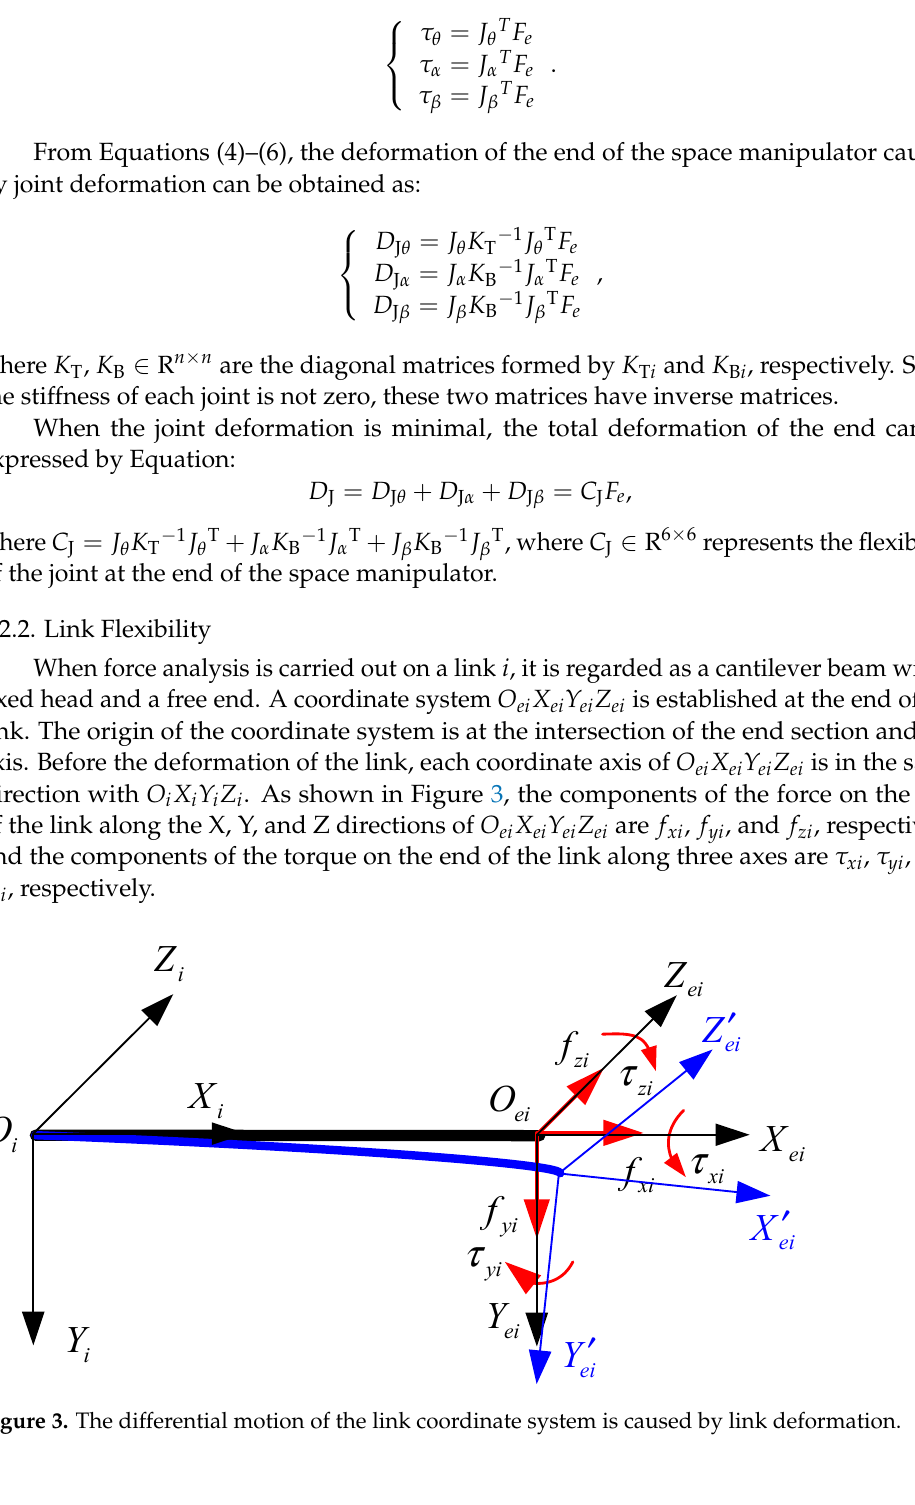
O X Y Z after de- d of the coordinate system ' ' ' ' ei ei ei ei Li